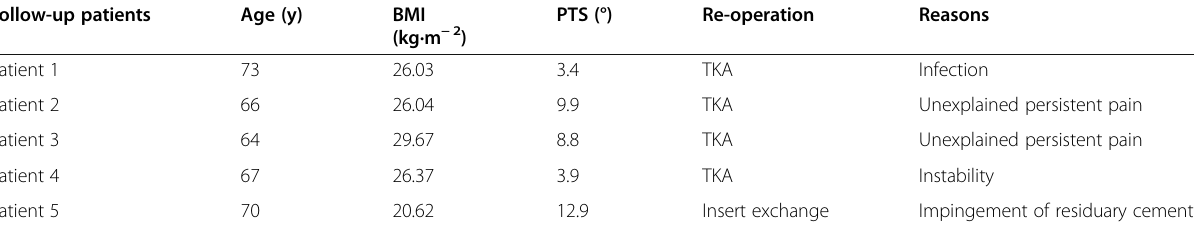
Table 3 The baseline characteristics and re-operation reasons of the patients Follow-up